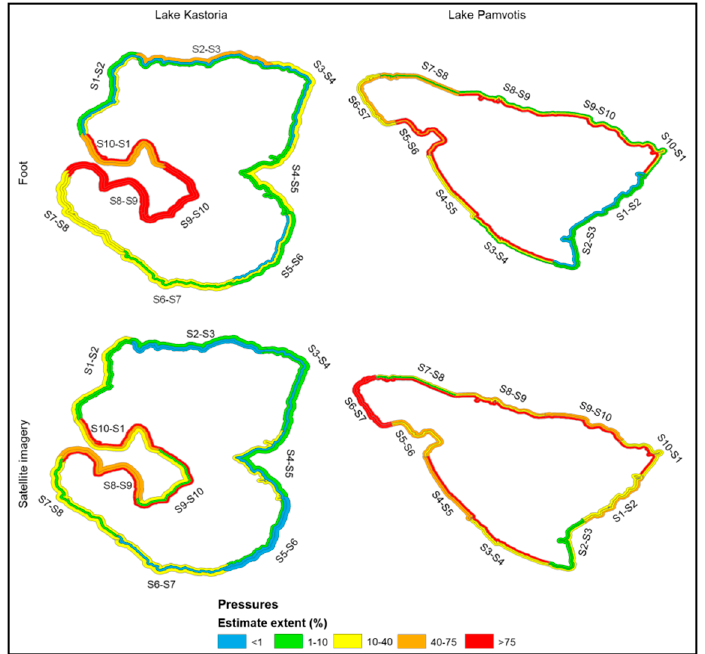
Figure 1. Estimate extent (%) of littoral and riparian (0–15 m and 15–50 m) land uses pressures in each area between HPs from two different approaches (foot-based approach and satellite imagery) in lakes Kastoria and